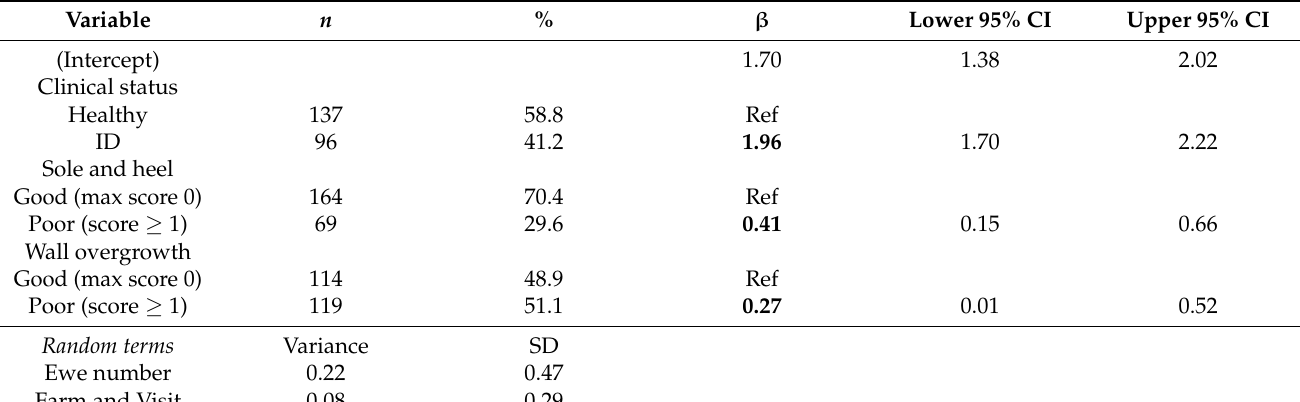
Table 11. Linear mixed effects model of the load of Dichelobacter nodosus on positive feet only, from 233 foot-level observa-